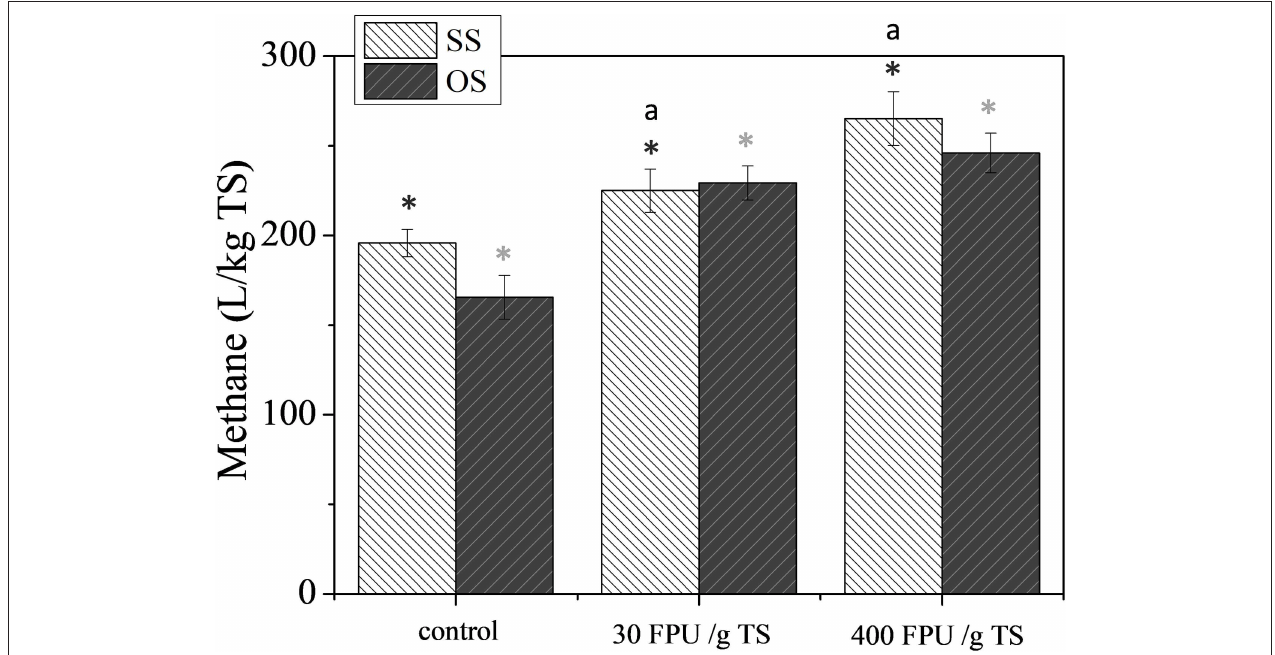
FIGURE 4 | The effect of enzymatic pretreatment on the methane potential of SS and OS. The results are mean ± SD from six different measurements ( N = 6). The statistical difference with the control (untreated biomass) is indicated by an asterisk above columns, whereas statistical difference among values is indicated by different letters above columns (Mann Whitney u